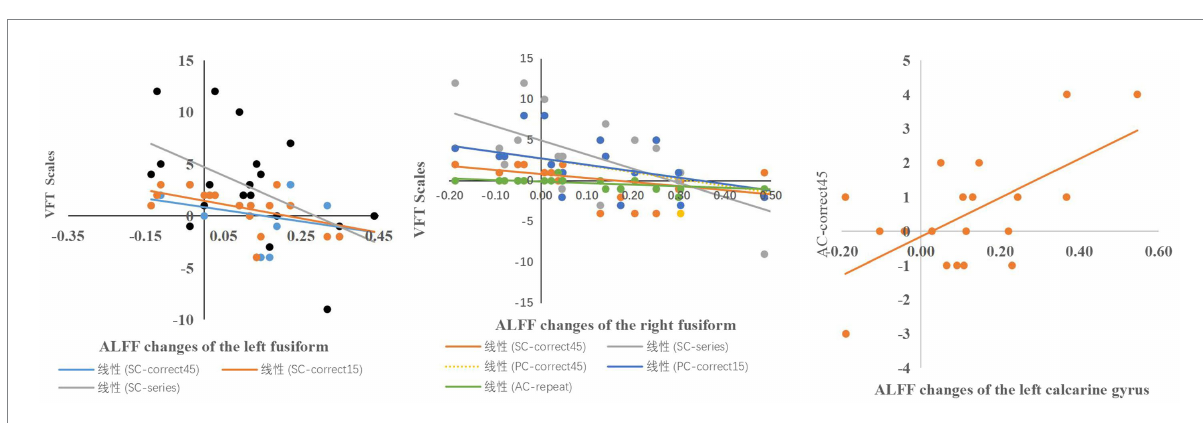
FIGURE 5 Correlation between the variability of ALFF and the variability of VFT task